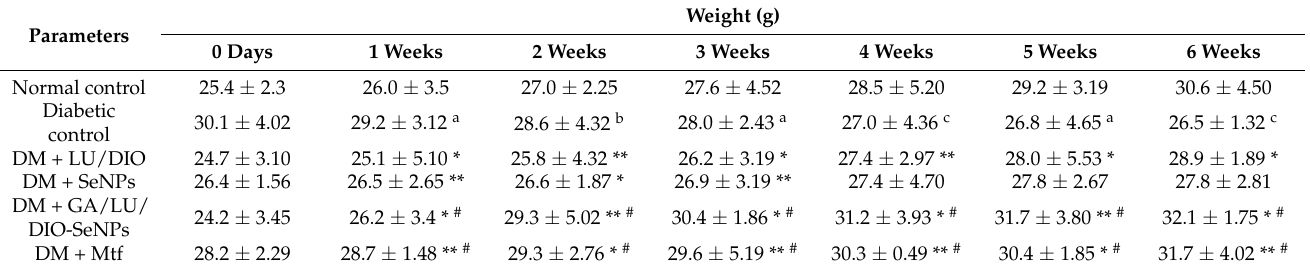
Table 1. Effect of flavonoid formulation (LU/DIO), SeNPs, and GA/LU/DIO-SeNPs on weight, in diabetic mice.